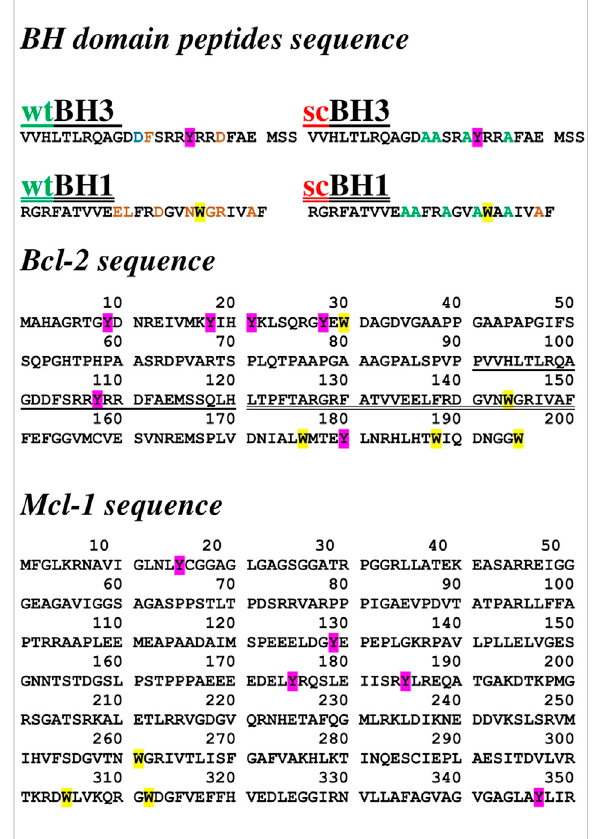
FIGURE 1 Amino acid sequences of Bcl2 BH1 and BH3 peptides, and Bcl2 and Mcl1